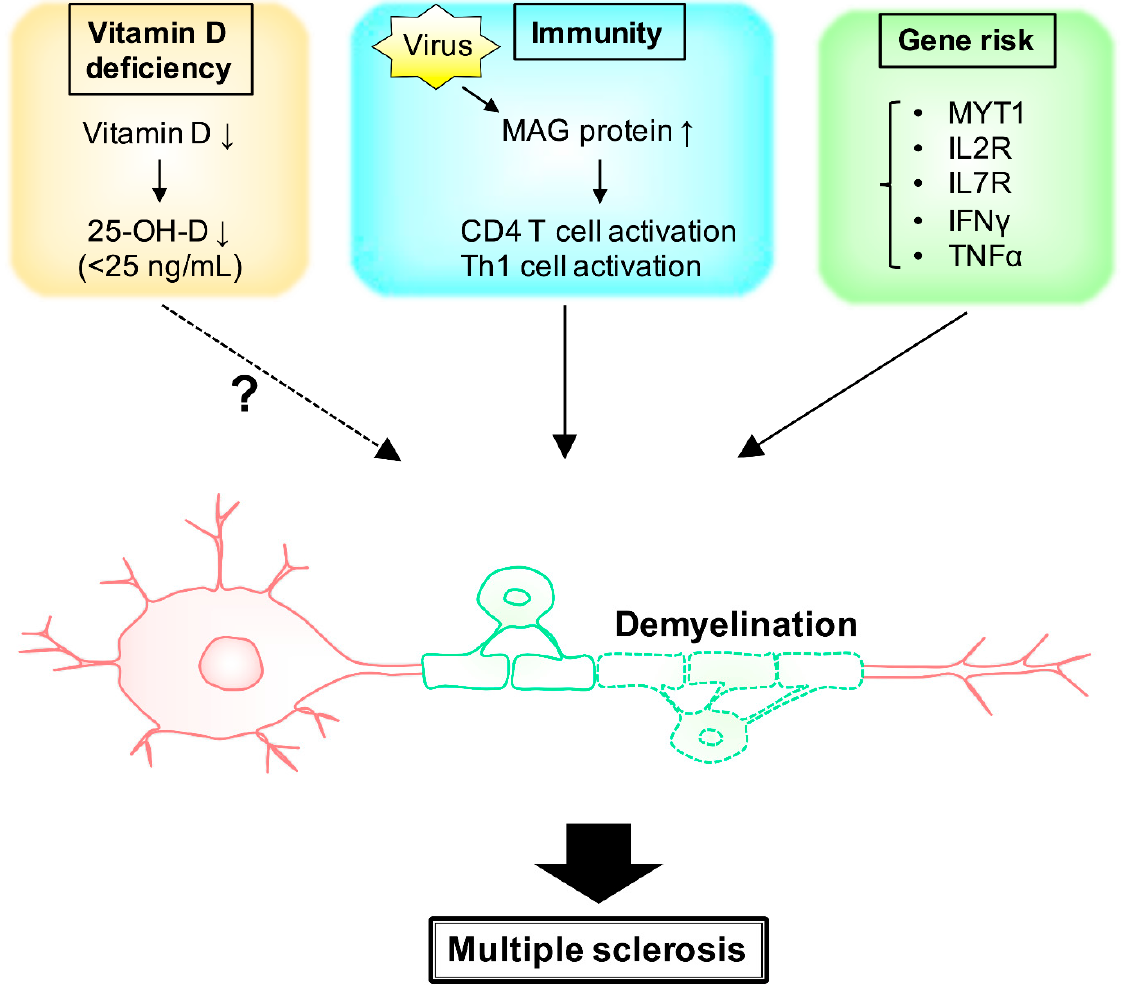
Figure 1. Schematic diagram of some putative major factors associated with multiple sclerosis. Deficiency of vitamin D results in demyelination. The levels of 25-OH-D, a metabolite from vitamin D, is one of the risks of MS. MAG proteins, as well as signaling molecules around immune cells, are also related to MS demyelination.